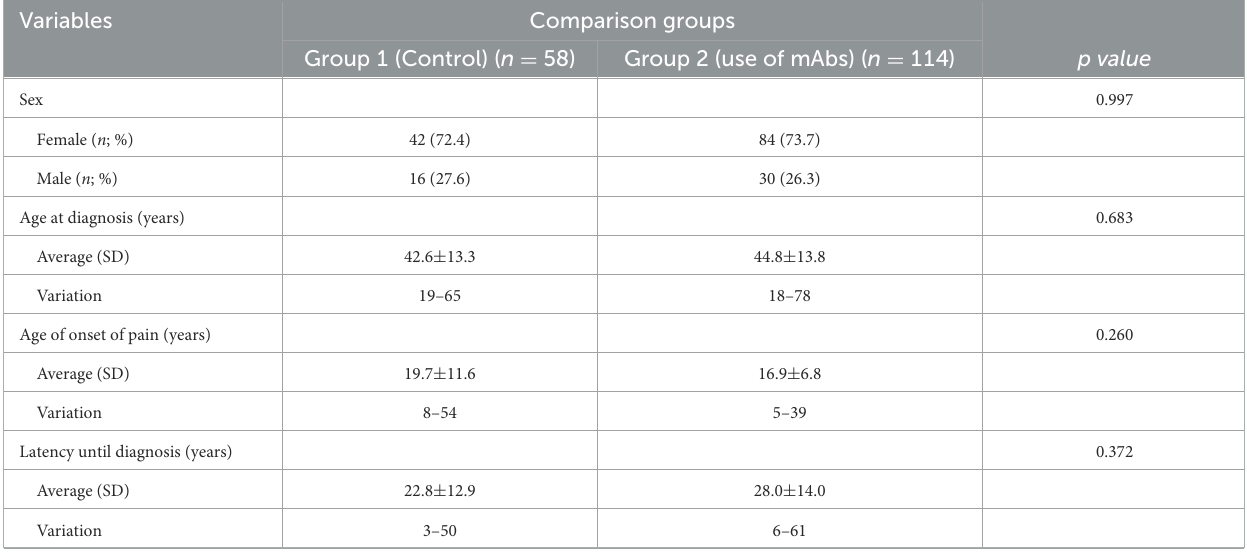
TABLE 2 Distribution of sex, age of pain onset and latency until diagnosis of 172 patients with chronic migraine and medication overuse headache. Variables